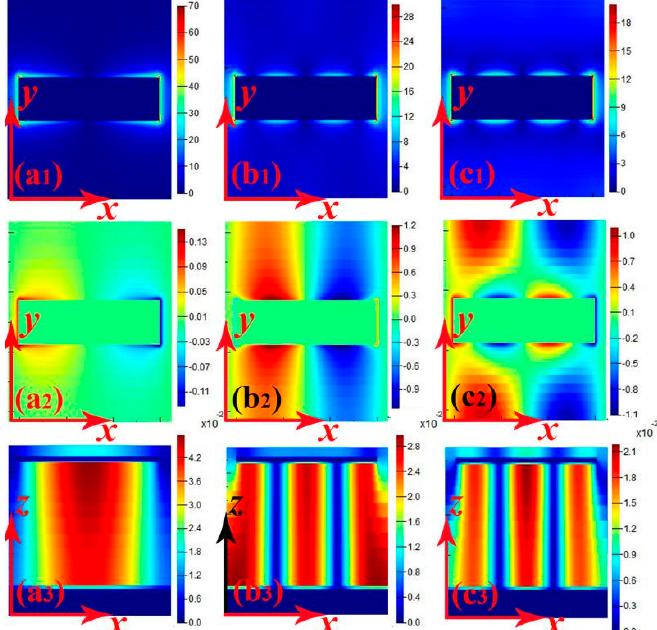
Figure 2. Field distributions of | E | ( a 1 ), real Ez ( a 2 ), and | Hy | ( a 3 ) for resonance at 1.316 THz; Field distributions of | E | ( b 1 ), real Ez ( b 2 ), and | Hy | ( b 3 ) for resonance at 3.474 THz; Field distributions of | E | ( c 1 ), real Ez ( c 2 ), and | Hy | ( c 3 ) for resonance at 4.245 THz.